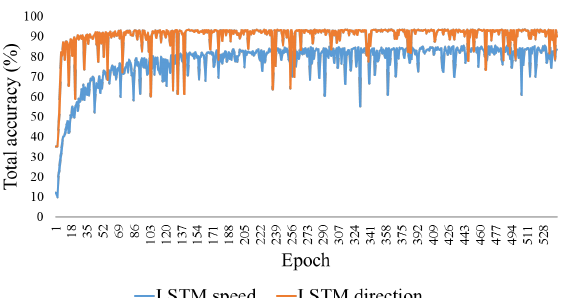
Figure 1: Learning curves for testing samples.